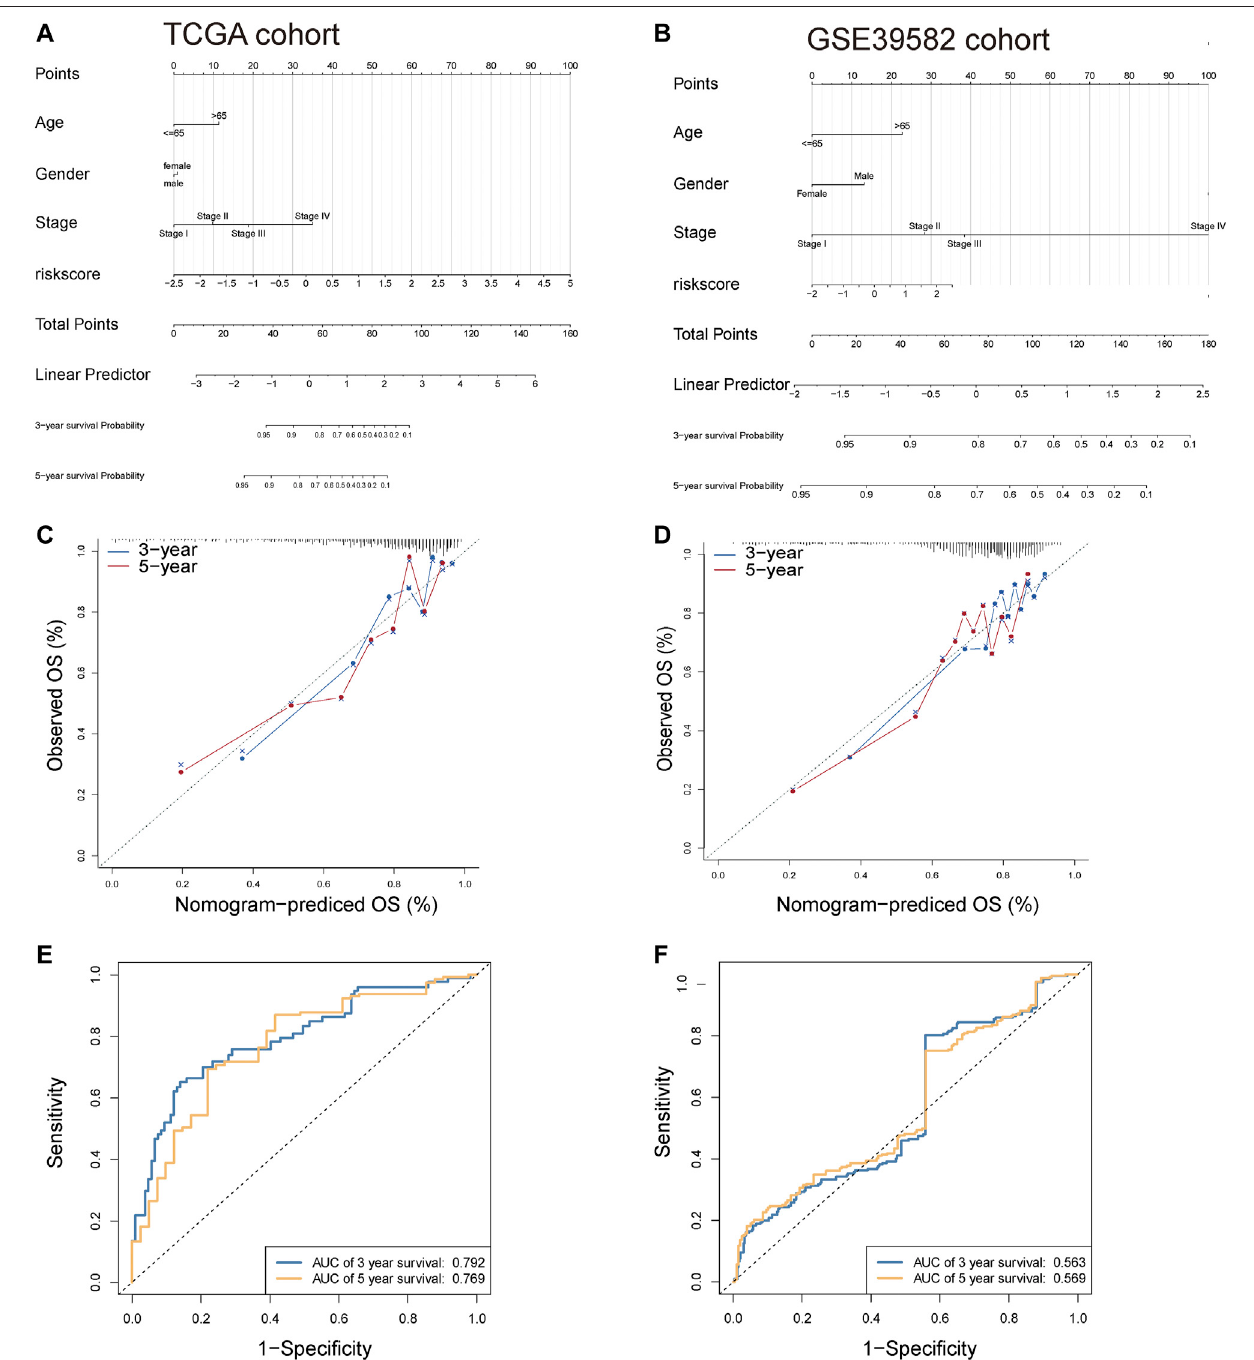
FIGURE 6 | Construction of nomogram for OS at 3 and 5 years in CRC. (A,B) The nomogram consists of the clinical features (age, sex, and stage) and risk score. The variable scores were summed to give the total points, and the total point line is shown at the bottom of the nomogram. (C,D) Calibration plots were established to comparetheproposednomogramwithanidealmodel. (E,F) AUCexperimentsonthenomogrammodelsuggestedthatthismodelhadahigheraccuracyinOSat3and 5 years.